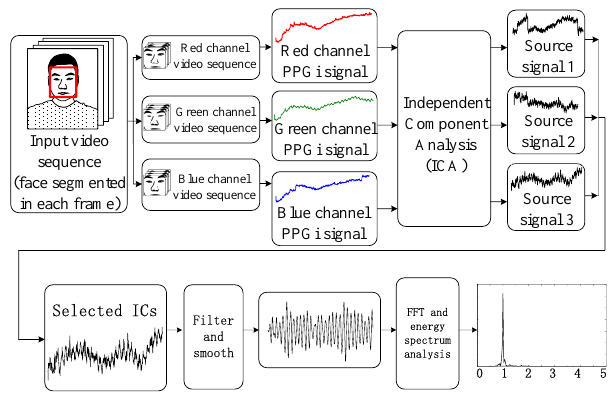
Fig 2. The automated method we applied to recover the cardiac pulse.